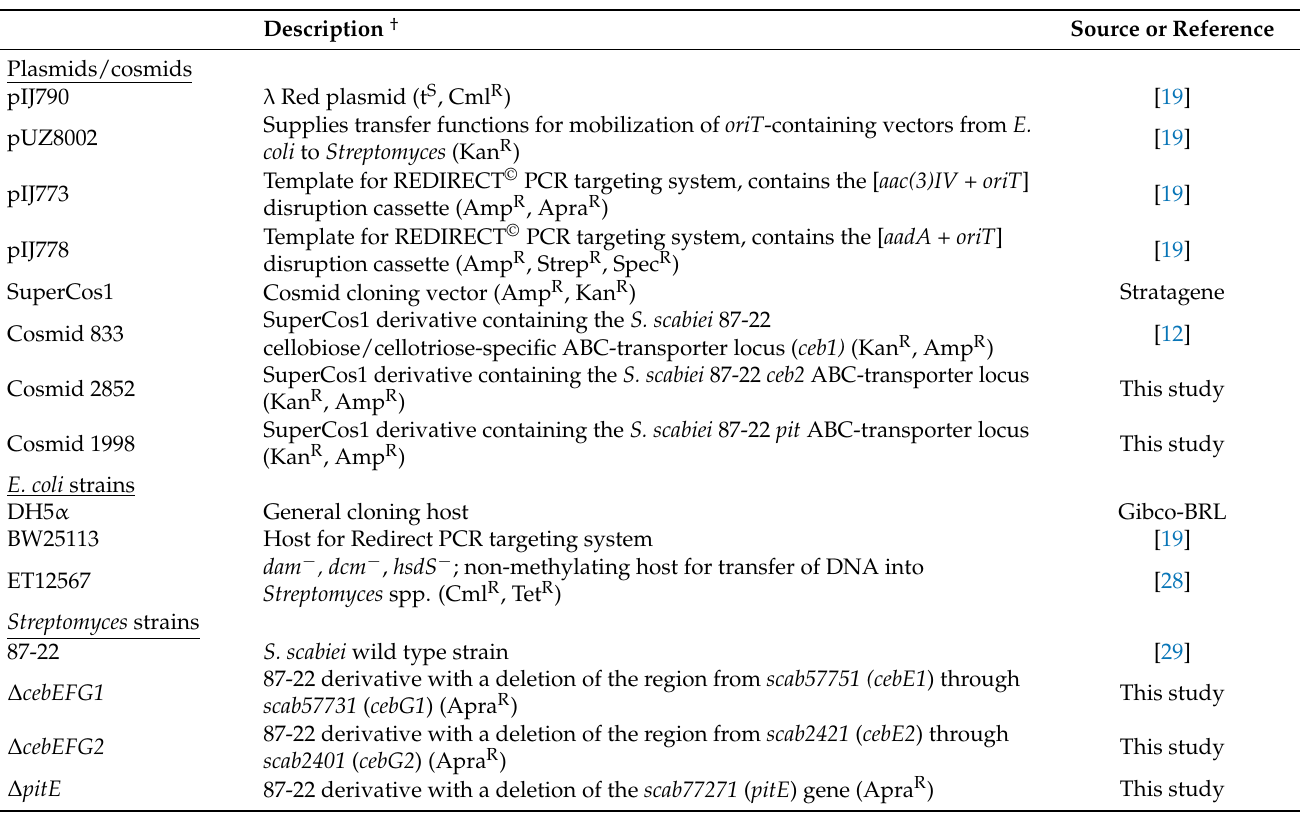
Table A1. Bacterial strains, plasmids, and cosmids used in this